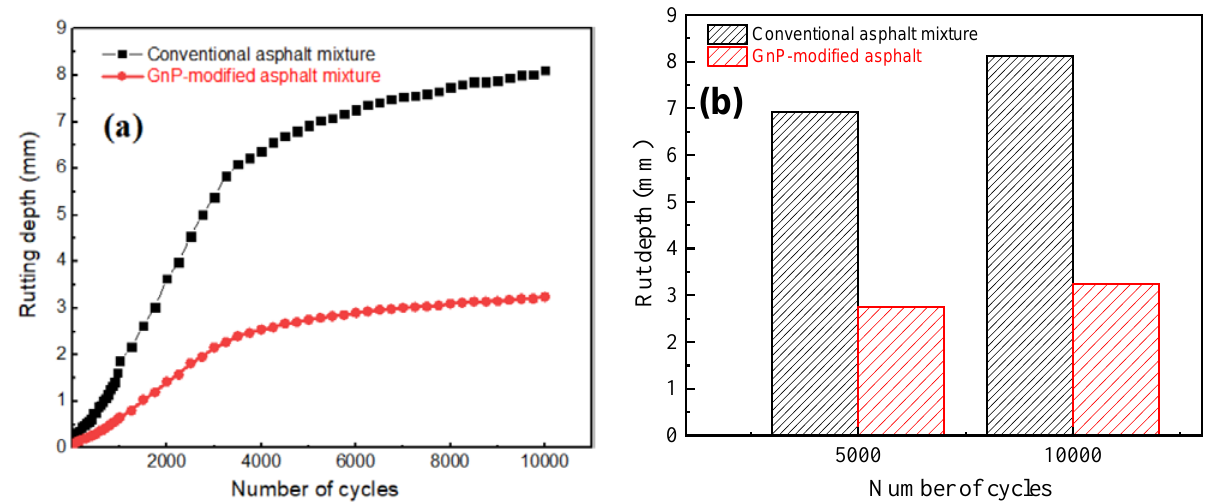
Figure 12. Rutting depth analysis of unmodified asphalt mixture and 1 wt% GnPs-modified asphalt mixture.